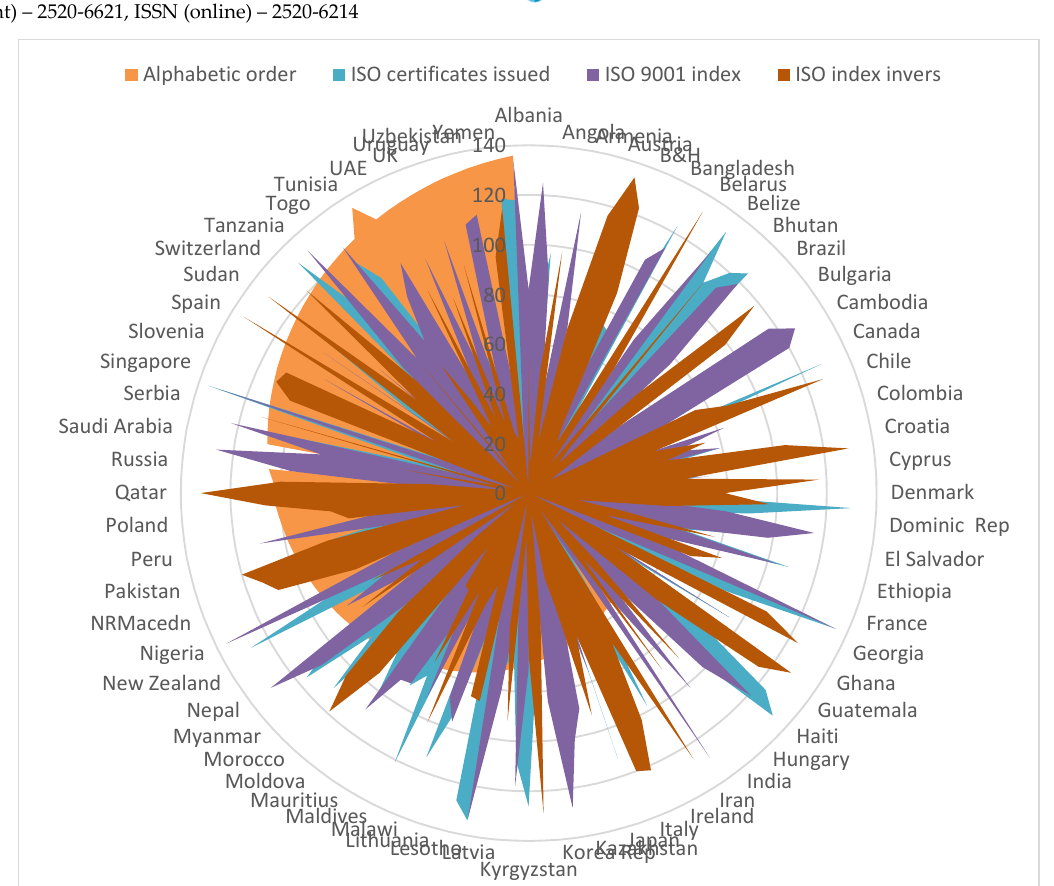
Figure 4. Radar of (1) alphabetic order (green), (2) number of ISO 9001 certificates issued (light blue), (3) ISO 9001 index (yellow), and (4) ISO index invers (dark